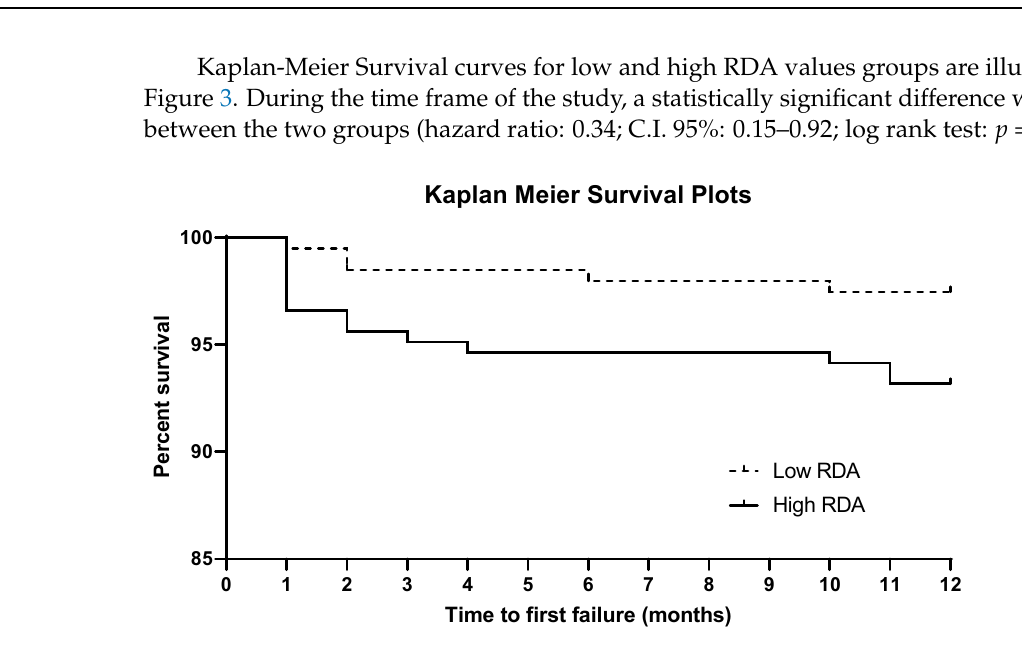
Figure 3. Kaplan-Meier survival plots for the two groups.